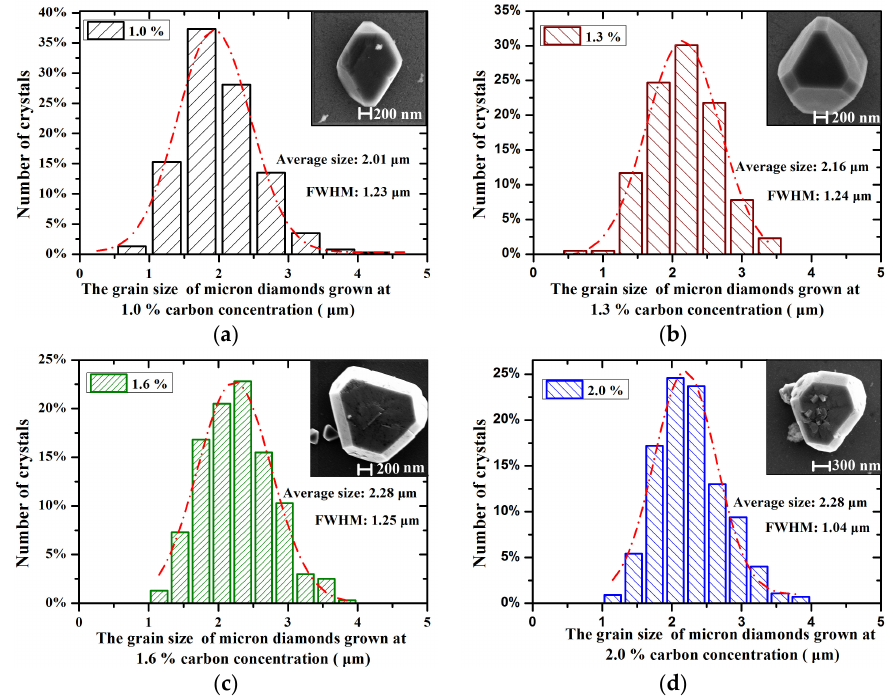
Figure 3. The grain size distribution of CVD microcrystalline diamonds at carbon concentrations of ( a ) 1.0%, ( b ) 1.3%, ( c ) 1.6% and ( d ) 2.0%, and their FESEM micrographs under the identical conditions.